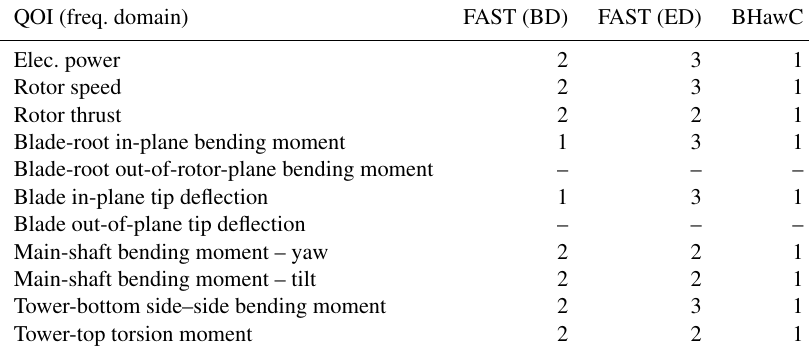
Table 3. The tools FAST (BD), FAST (ED), and BHawC ranked according to how well their PSD results compare to the experimental measurements for each QOI. No value indicates that no discernible difference could be seen among the different tools for that QOI. QOI (freq.